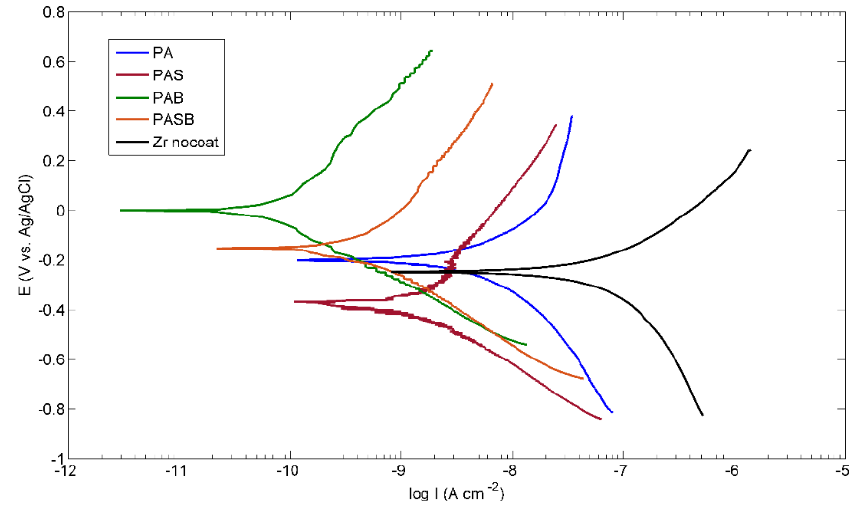
Figure 8. Polarization curves in Ringer’s solution for the uncoated and PEO-coated samples. Table 8. Results of potentiodynamic corrosion tests in Ringer's solution for the uncoated and PEO- coated samples.